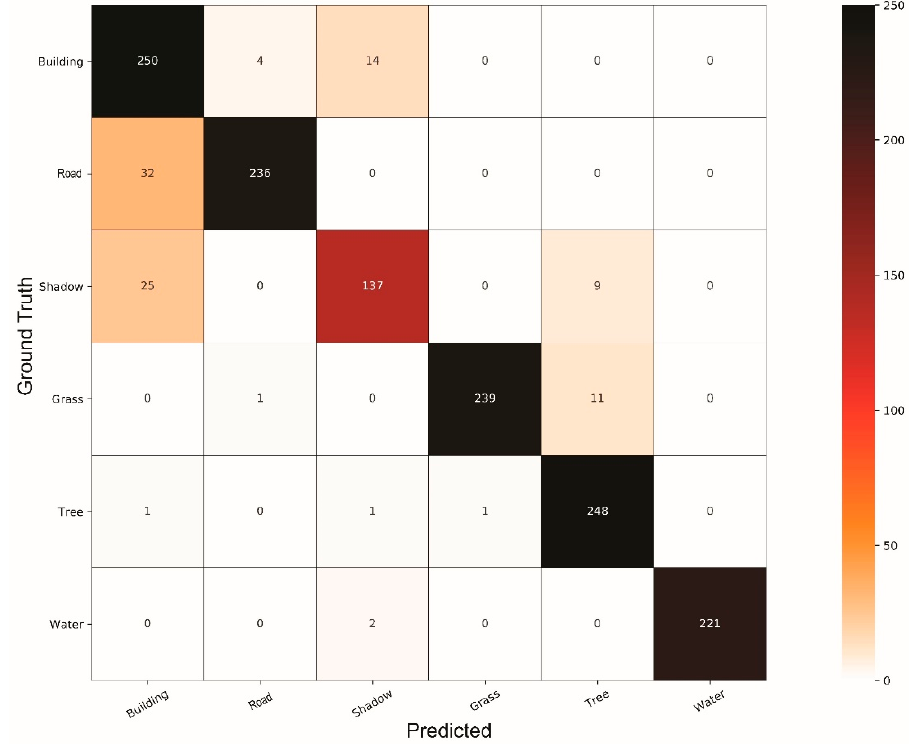
Figure A9. Confusion matrix of the XGB model for 50 cm image.